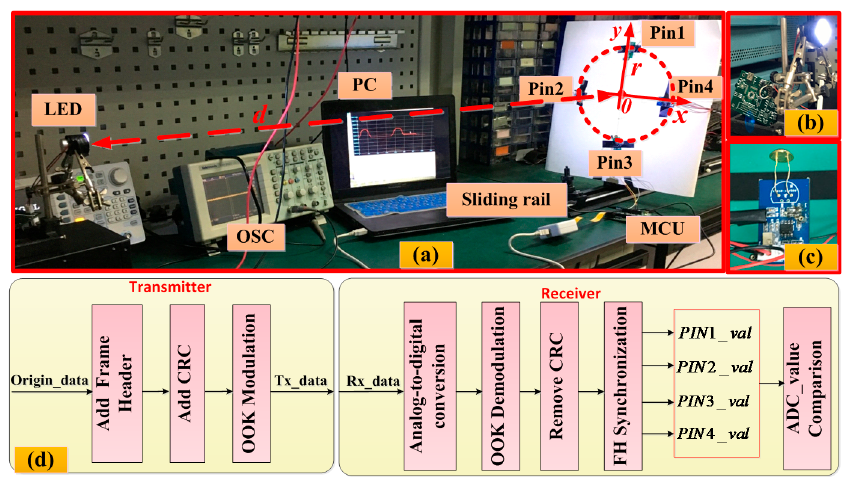
Figure 4. ( a ) The experimental setup of testing the receiver’s circle radius and height; ( b ) The transmitter part; ( c ) The receiver part; ( d ) The block diagram of the proposed VLC positioning system. CRC: cyclic redundancy check.